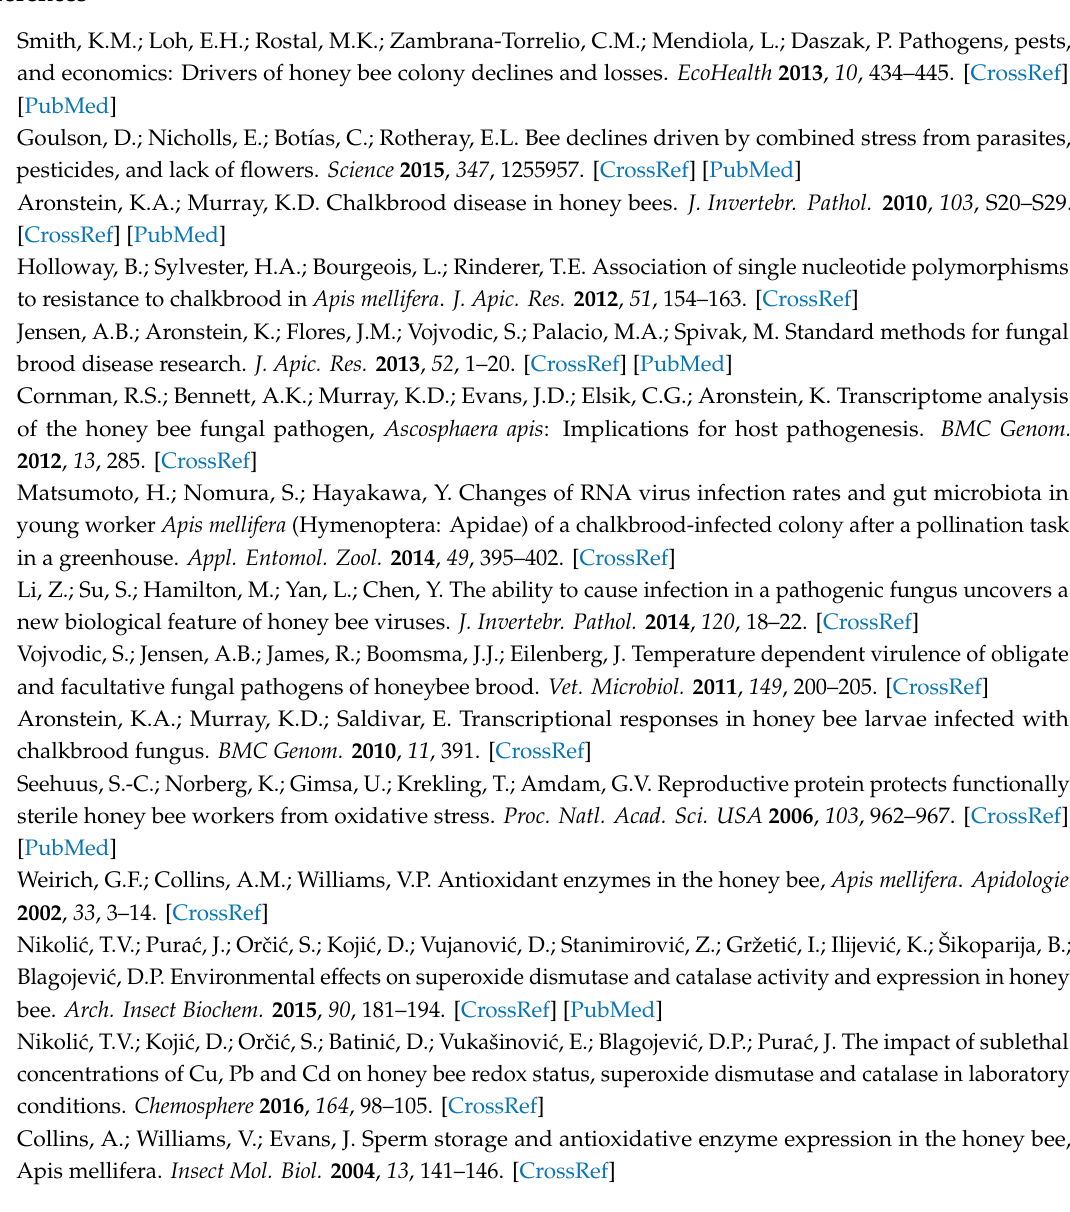
Figure S1: Detection of A. apis in the gut sample from A. apis -infected larvae and controls by PCR test at 3 days post-infection. Figure S2: All the control larvae developed well without any obvious disease symptoms (A); the Apis-infected larvae developed typical chalkbrood symptoms at 6 days post-infection (B). Table S1: A total of 80 unique significantly di ff erential metabolites were identified between A. apis -infected larvae and controls.